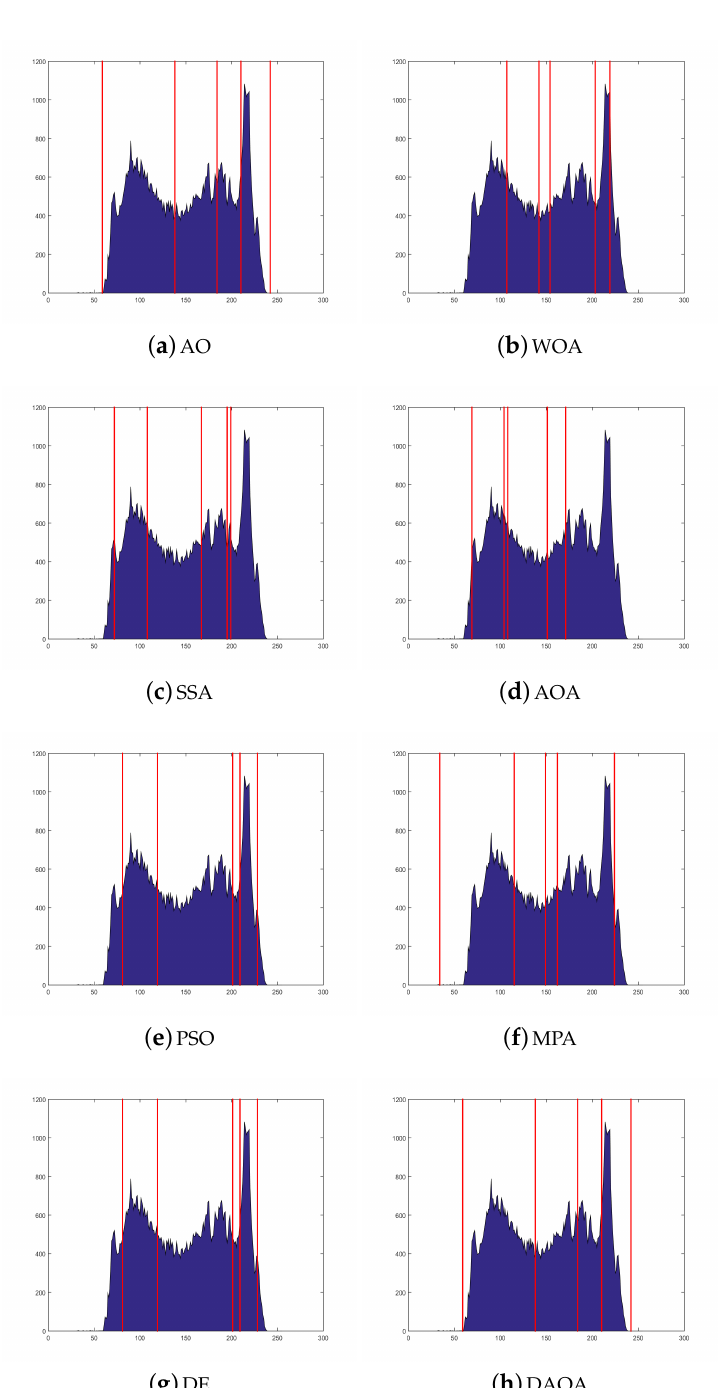
Figure 14. The histogram image (Test 8) by the comparative methods when the threshold value is